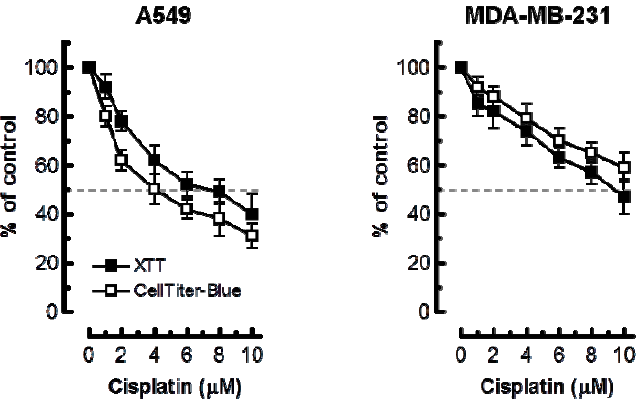
Figure 4. Cisplatin sensitivity of the indicated cell lines evaluated by the 96-well plate XTT (solid squares) and CellTiter-Blue (open squares) assays. Bars, SE.